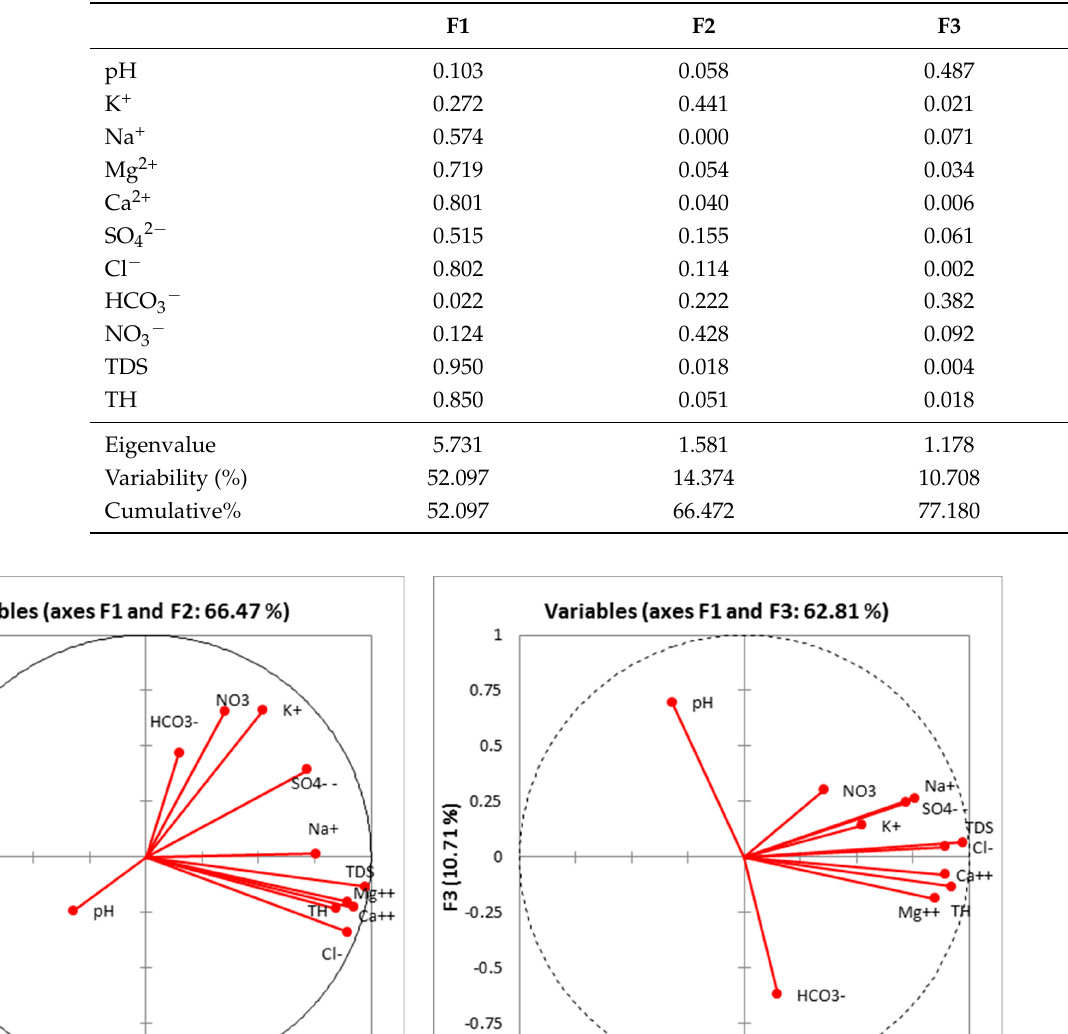
Table 5. Factor-loading matrix, eigenvalues, total, and cumulative variance values of the study area.